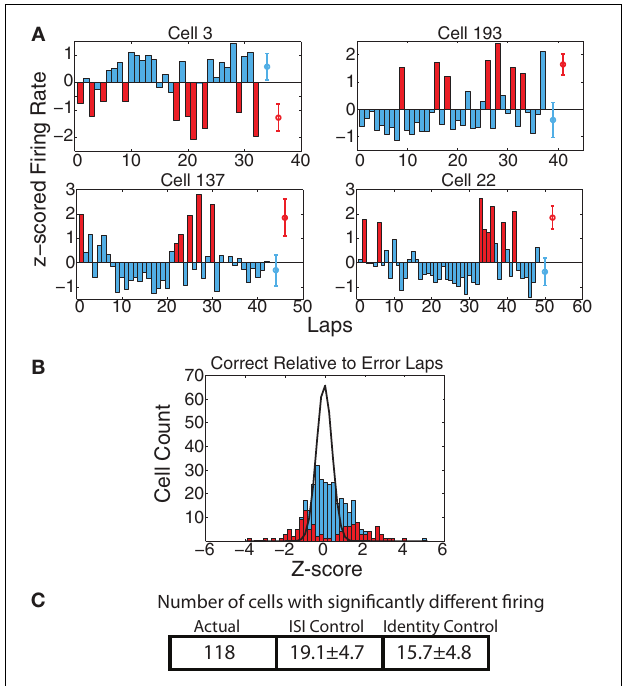
FIGURE 8 | (A) Examples of cells with strong changes in firing rate on correct laps vs. laps on which the animal made an error. Red bars indicate error laps, blue bars correct laps. Red and blue circles represent average firing rates over both types of laps. (B) z error (correct) comparison. Because there were too few error laps, we only calculated z error (correct). Bars indicate overall distribution, with red bars indicating cells found to have a significant firing difference by KS test. Black line indicates expected distribution from ID shuffle. (C) Number of cells with significantly different firing (by KS test of the distribution of firing rates on correct laps compared to error laps) relative to expected number of cells from two control conditions with inter-spike-intervals (ISI) or lap identity (ID) randomly shuffled.